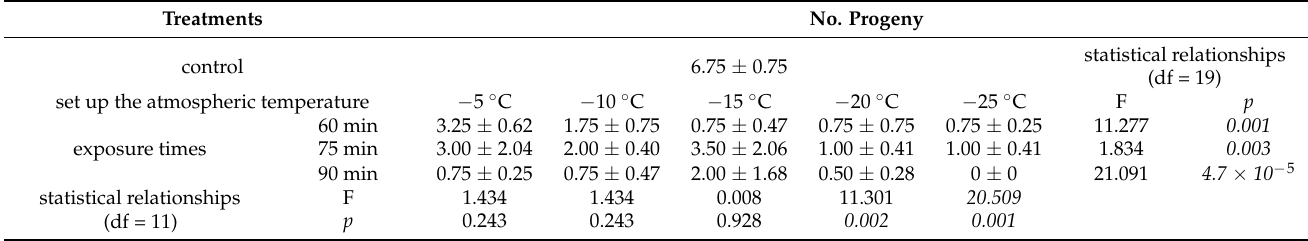
Table 2. The observed progeny production of S. granarius 45 days after the cold treatment., Statistical inferences with p < 0.05 were considered